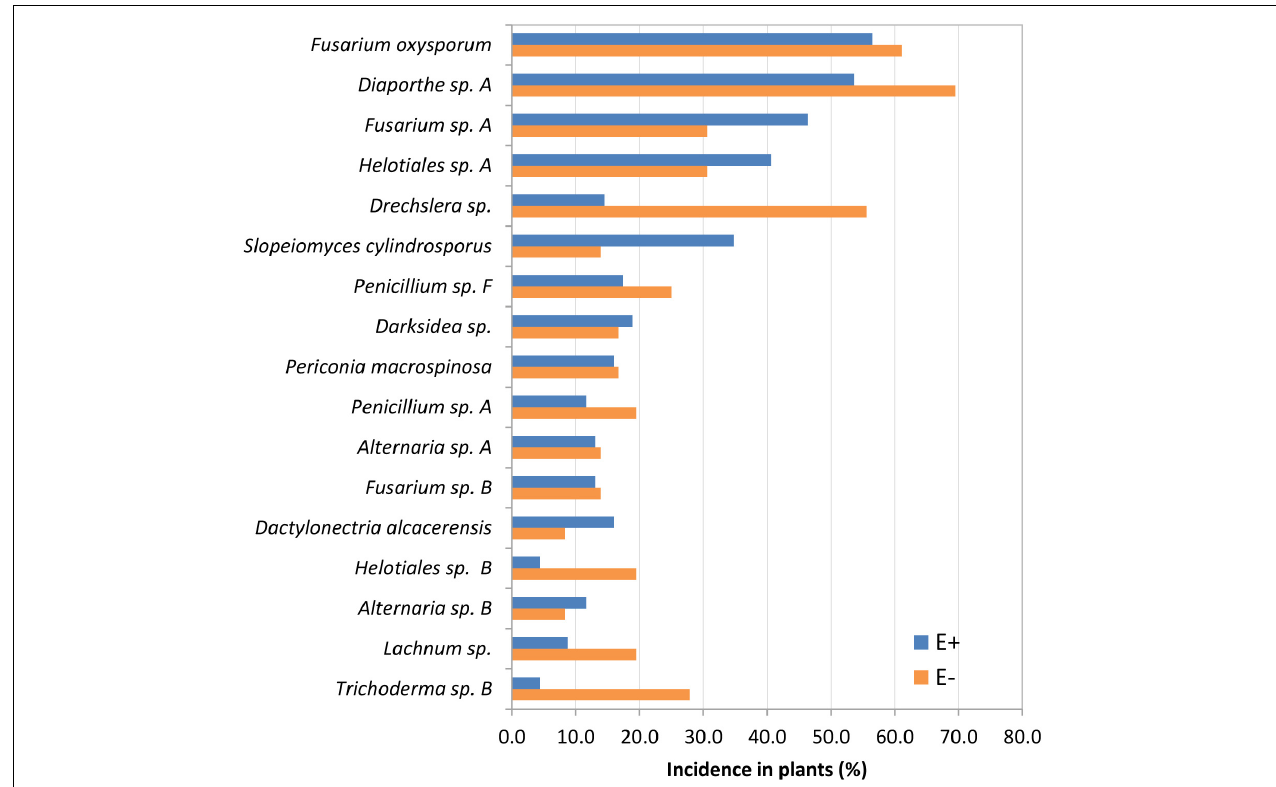
FIGURE 6 | Incidence in plants of Festuca rubra subsp. pruinosa from marine cliffs infected (E+) and not infected (E–) by Epichloë festucae of root species that constitute the core and abundant classes of the culturable mycobiome.